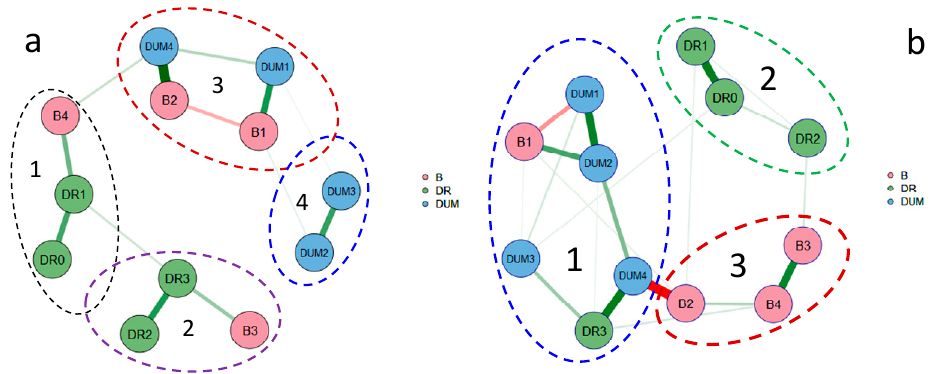
Figure 10. The network plots of the similarity (in R-statistics) between monitoring sites data of surface ( a ) and bottom ( b ) in the Ukrainian part of the Danube nearshore area in August 2018. The names of sampling stations as in Table 2. Sets of stations in the legend. The line thickness between stations reflects the correlation value; green is positive, red is negative. Clusters marked by dashed lines and numbered.